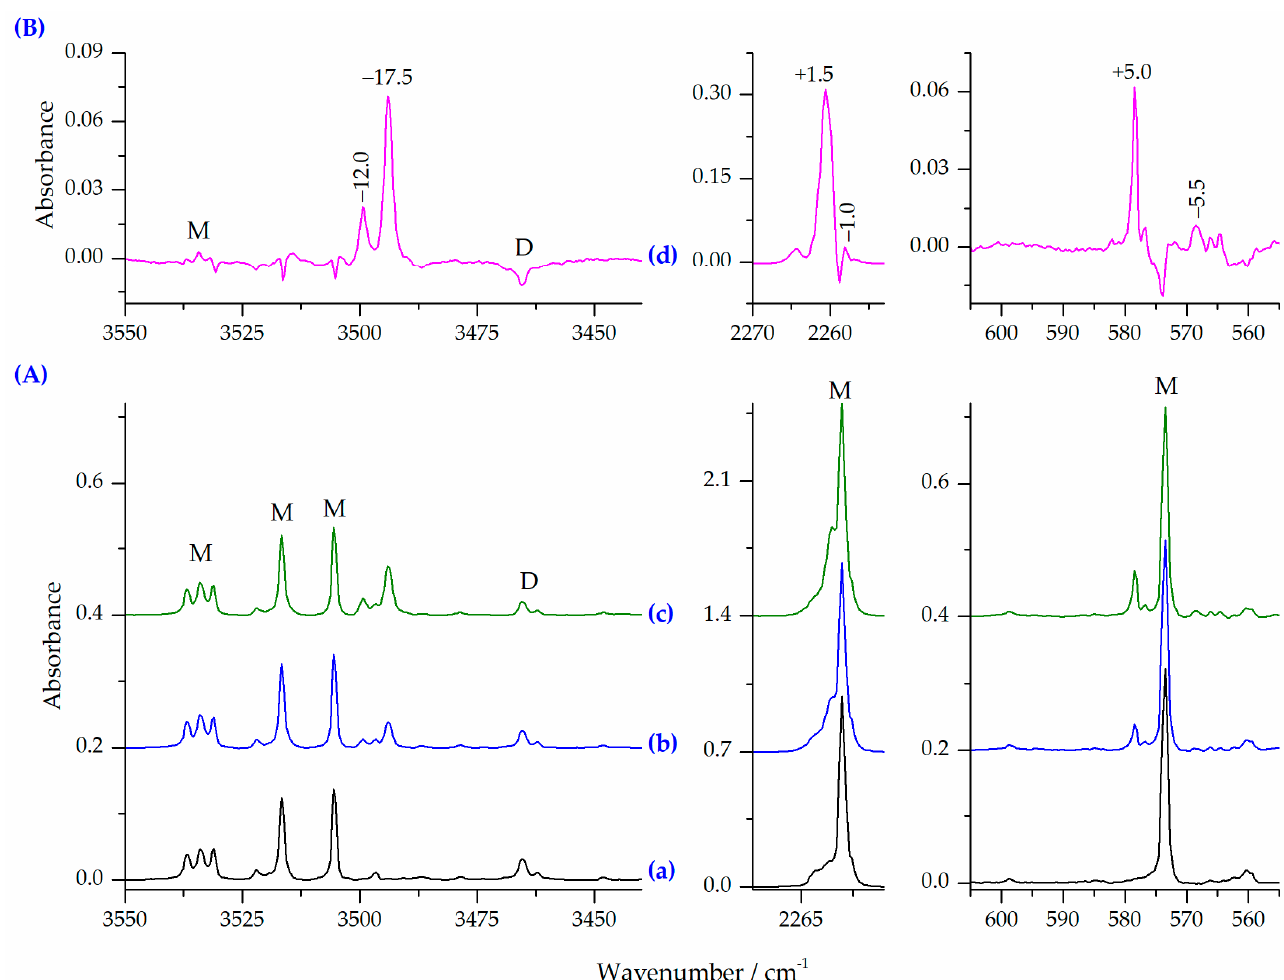
Figure 4. ( A ) The ν NH, ν as NCO and δ NCO regions in the spectra of matrices: HNCO/Ar = 1/6000 (a), HNCO/N 2 /Ar = 1/2/5600 (b), HNCO/N 2 /Ar = 1/4/5600 (c); ( B ) the difference spectrum (d) obtained by subtracting the spectrum (a) from the spectrum (c) (pink trace). Letters M and D denote the HNCO monomer and dimer bands, respectively. Table 5. Selected wavenumber shifts (cm − 1 ) calculated for the 1:1 complexes using the MP2,